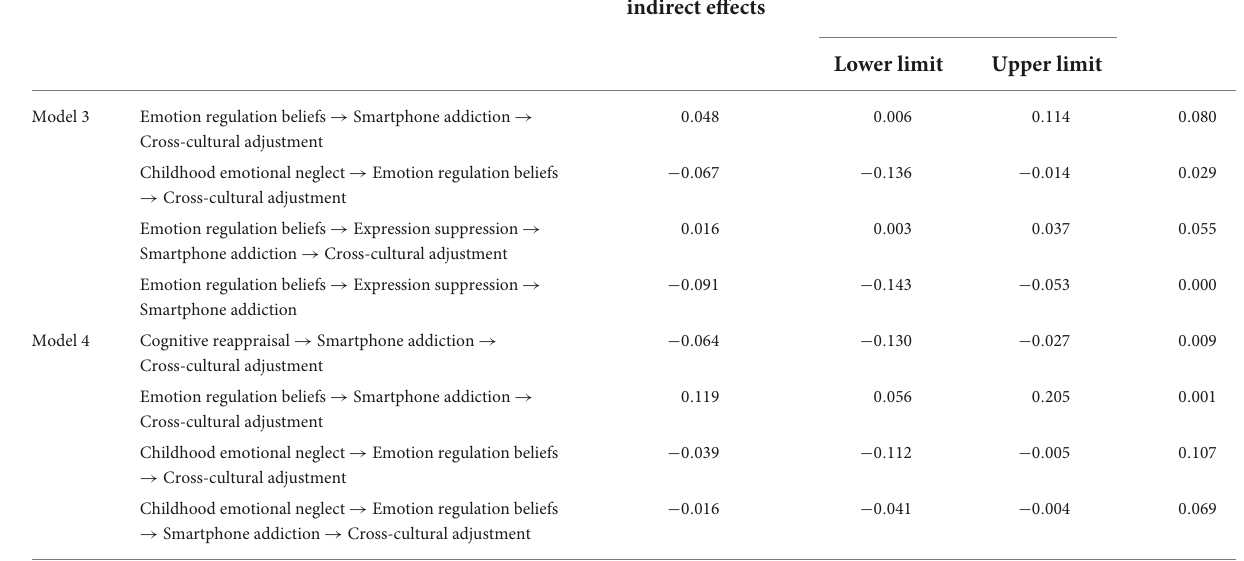
TABLE 3 Bootstrap-based specific mediation test